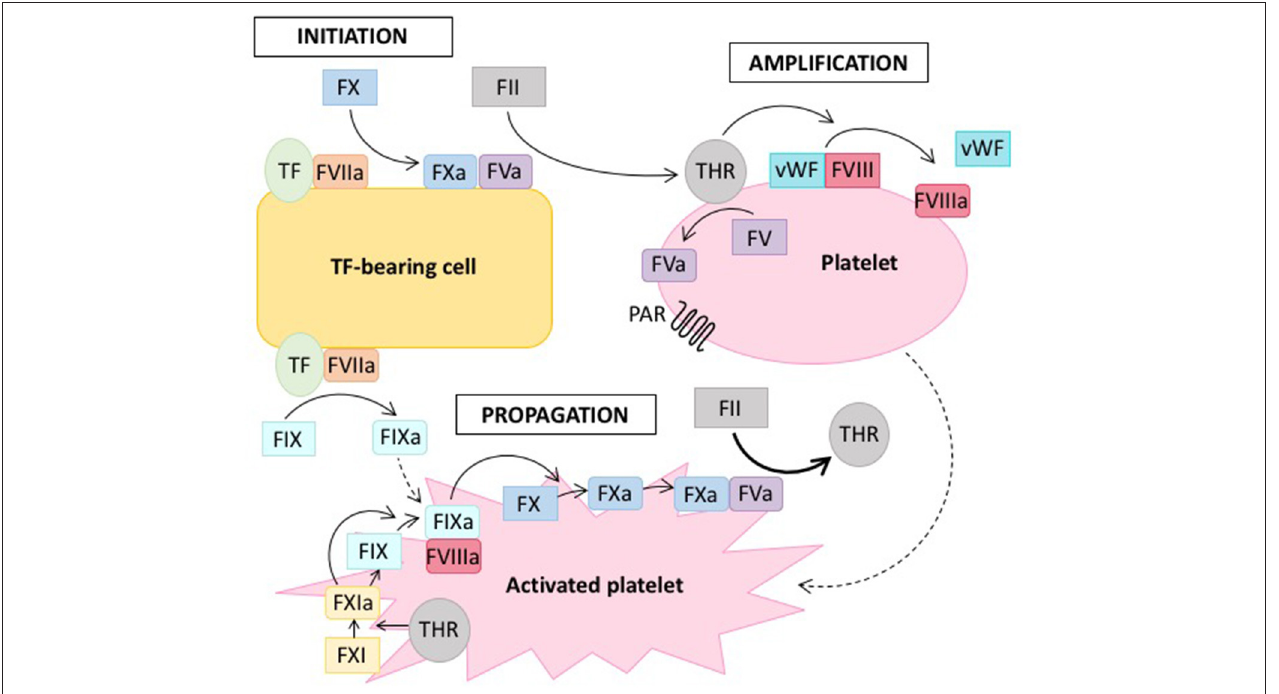
FIGURE 1 | Cell-based model of coagulation. On the surface of tissue factor (TF) -bearing cells, coagulation is initiated by TF, which leads to the generation of a small amount of thrombin (THR) from prothrombin (FII) (initiation phase). Thrombin amplifies the initiation signal by activating platelets via protease-activated receptors (PAR) and cofactors (FV, FVIII) on the platelet surface (amplification or priming phase). Large amounts of thrombin are then generated on the surface of activated platelets (propagation phase). Solid lines indicate proteolytic conversion of an inactive zymogen to its active form, dotted lines indicate activation. Adapted from reference